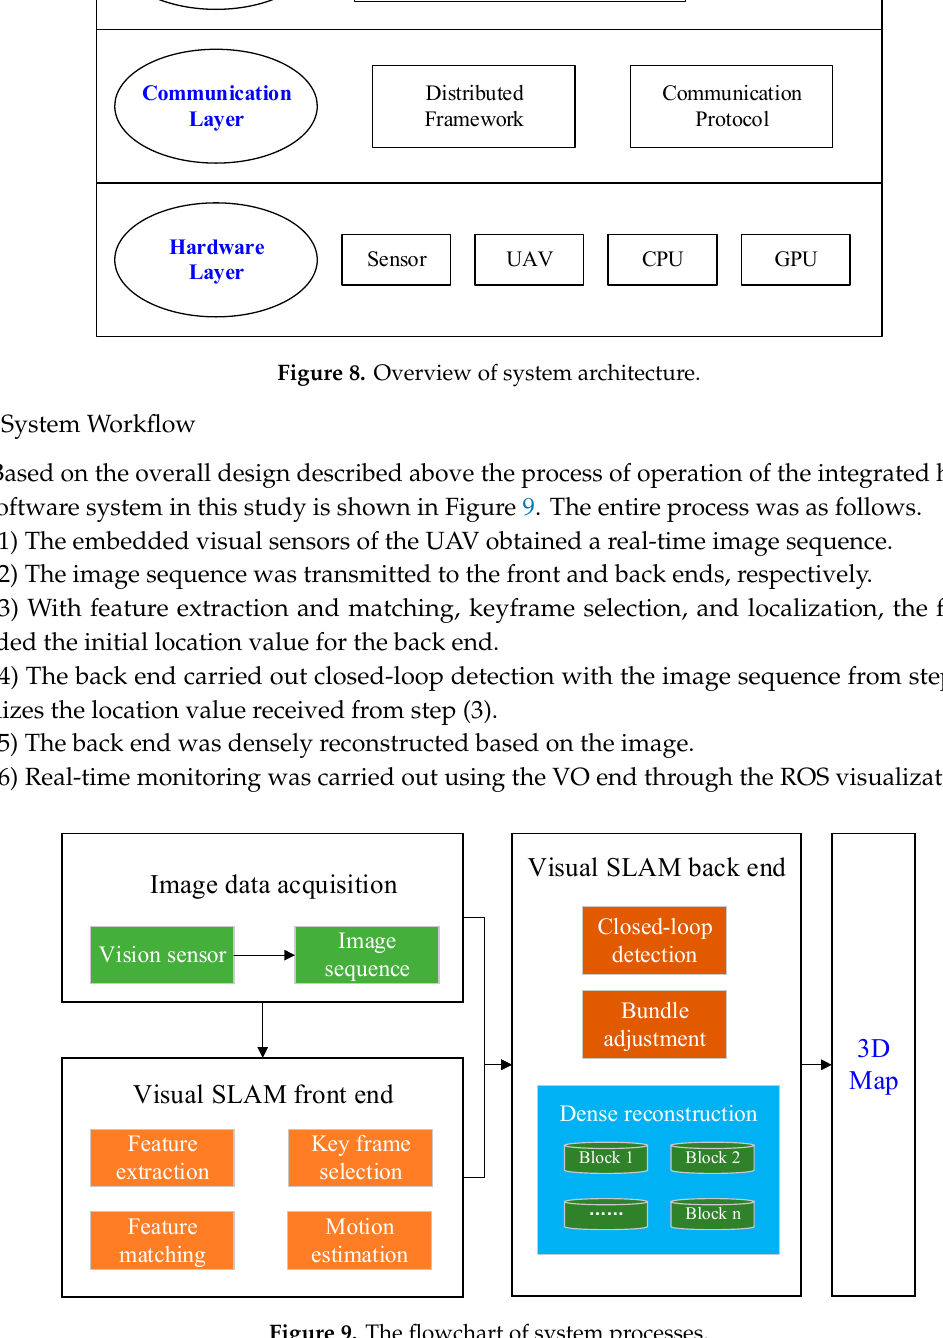
Figure 9. The flowchart of system processes.